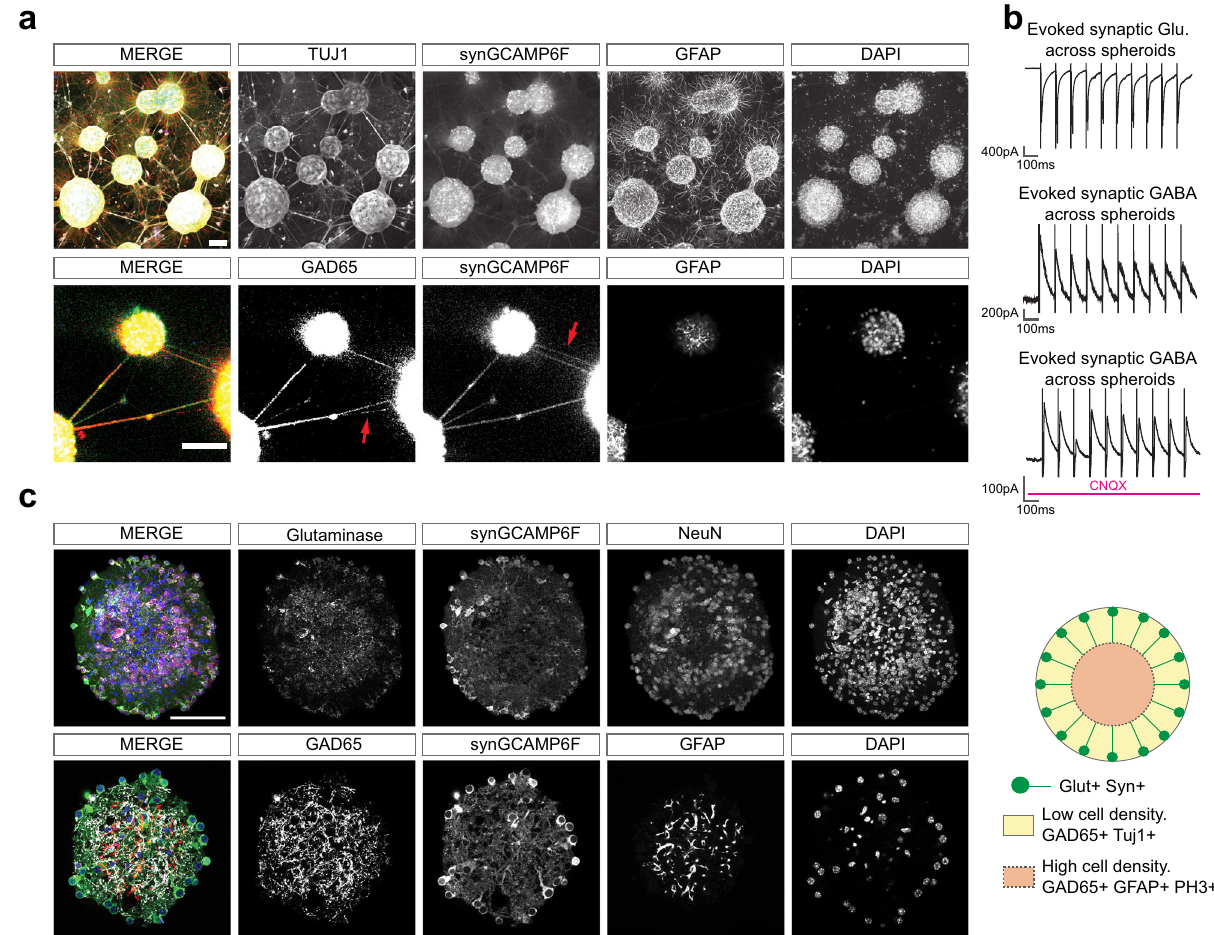
Fig. 3 Characterizing the cellular architecture of MoNNet. a Whole-mount immunostaining of four weeks old MoNNets. Top row: maxima projections showing Tuj1, Syn-GCaMP6f, GFAP and DAPI labeling. Bottom row: a confocal optical section showing co- or exclusive (red arrow) labeling of interconnections with GAD65 or synGCaMP6f signals, suggesting existence of excitatory as well as inhibitory signaling transmission across spheroids unit in MoNNets. Scale bars are 100 μ m. These representative experiments were independently repeated >3 times. b Electrophysiology recordings validating the existence of monosynaptic functional glutamatergic and GABAergic signal transmission across spheroids. For all recordings, a neighboring spheroid, located ~250 – 300 μ m, away was stimulated at 10 Hz. Top-to-bottom: representative 1 s trace of a cell held at − 70 mV showing robust evoked excitatory synaptic transmission across spheroids; representative 1 s trace of a cell held at 0 mV showing robust evoked inhibitory synaptic transmission across spheroids; representative 1 s trace of a cell held at 0 mV showing robust evoked inhibitory synaptic transmission during CNQX (10 μ M) blockade of glutamatergic transmission. c , Immunostaining of 2 weeks old individual spheroids vibratome sections (50 μ m thick) to visualize their cellular architecture. Glutaminase and NeuN immunolabeling revealed preferentially peripheral localization of glutamatergic cells, whereas the GAD65 and GFAP expression is preferentially localized in the inner regions. A schematic summary is shown on right. Scale bars are 100 μ m. These representative experiments were independently repeated >3 times. Also see Supplementary Fig. 7 for additional GAD65 stainings, Supplementary Fig. 8 for PH3 and activated Caspase3 labeling, and Supplementary Video 7 for Confocal z-stack showing the 3D cellular architecture of (ECM) ( p = 6.7×10 − 5 , GO:0030198) in upregulated genes in